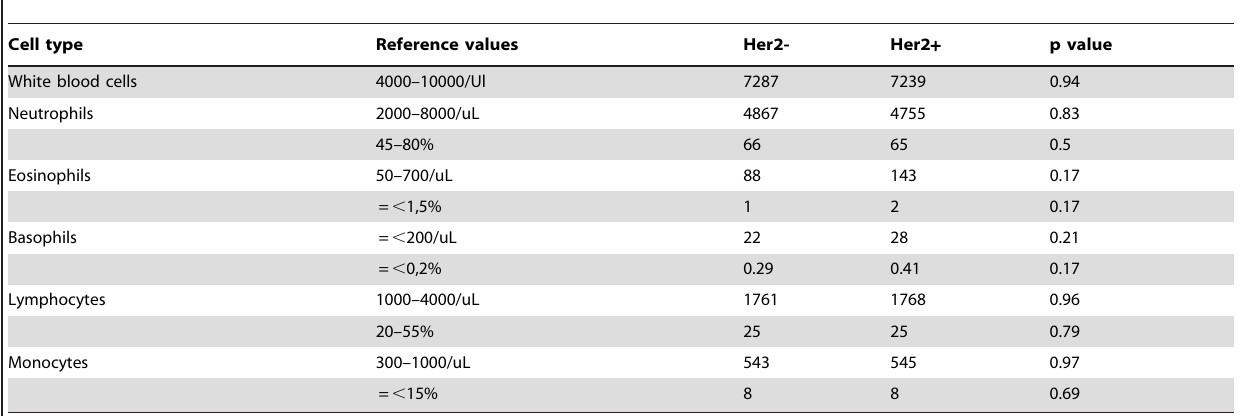
Table 1. PCR array 300 ng of total RNA was reverse transcribed with RT2 First Strand kit, diluted and amplified in 96 well Human Breast Cancer PCR Array plates PAHS-131Z (Qiagen, Romania). The array consists of 84 primer sets for genes involved in breast cancer (Table 2), 5 housekeeping genes for sample-to-sample normaliza- tion, and several controls for reverse transcription and PCR reactions. Cycling program settings were done as instructed by the Table 3. Patients’ differential blood count according to Her2 expression on the primary tumors.